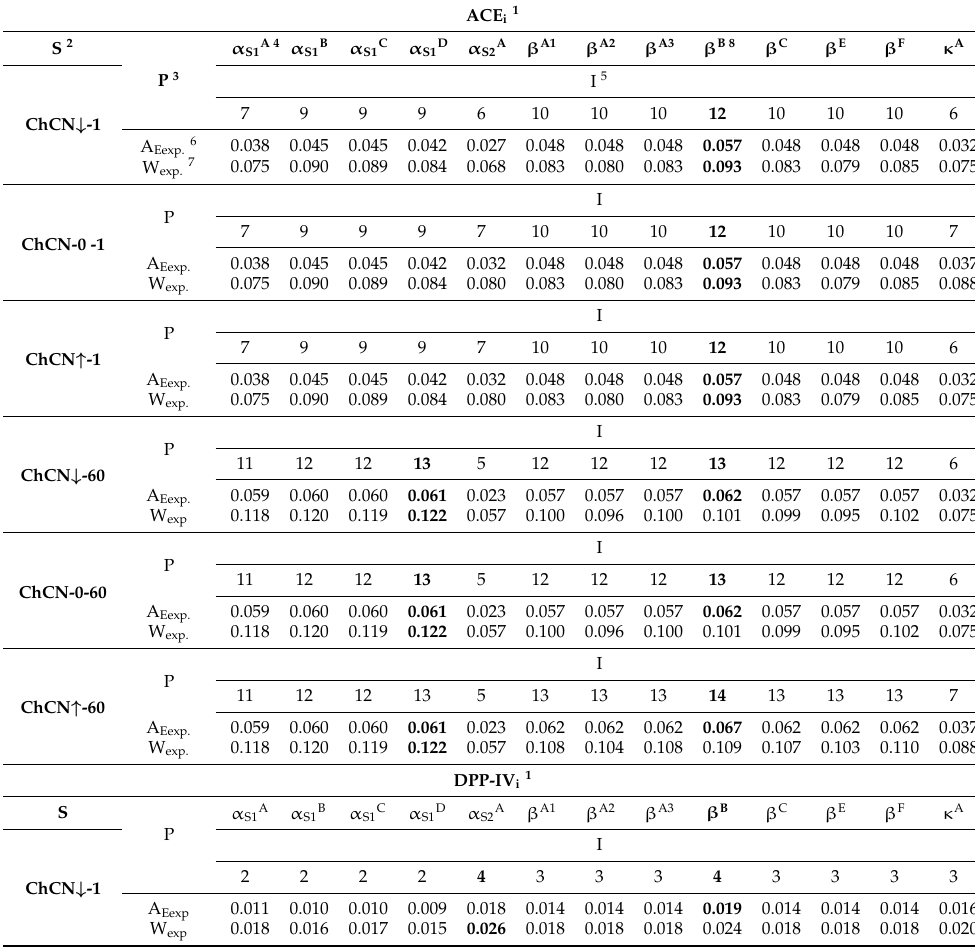
Table 7. Values of A Eexp. and W exp. calculated for the ACE- and DPP-IV-inhibitory activity of peptides released from different Gouda cheese